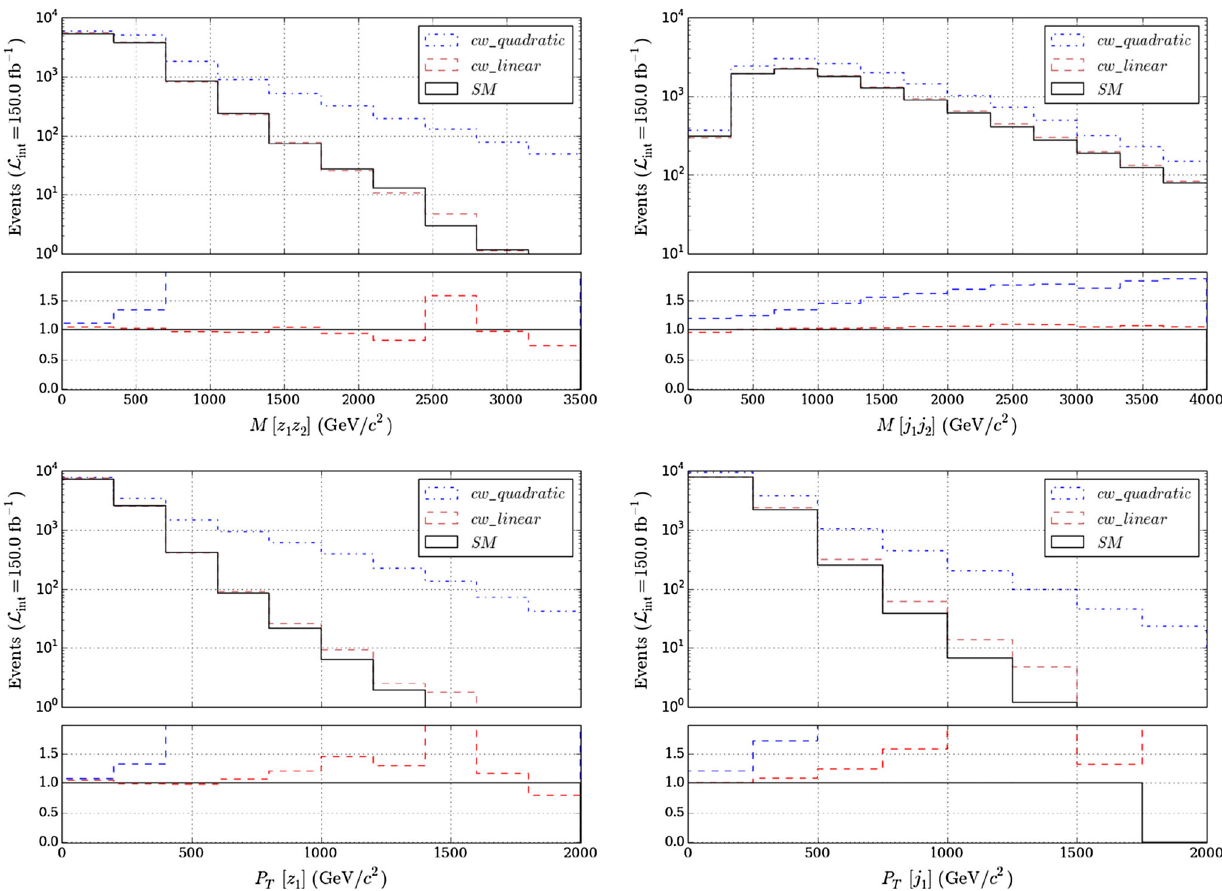
Fig. 4 Quadraticeffectsonsomekinematicdistributions.Theredlines represent the linear contribution to the cross section (dim = 6 interfer- ence with the SM) and the blue lines represent the previous contribution plus the purely dim = 6 term. We take the canonical values ¯ c W = 0 . 06 and (cid:2) = 1 TeV. The quadratic effects are relevant in general on the